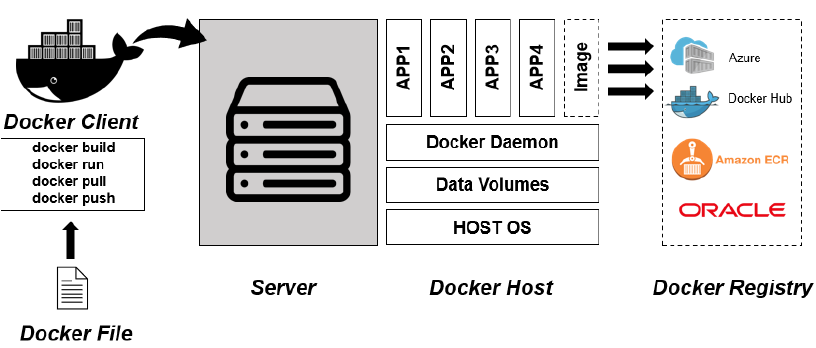
Figure 4. Docker Container key